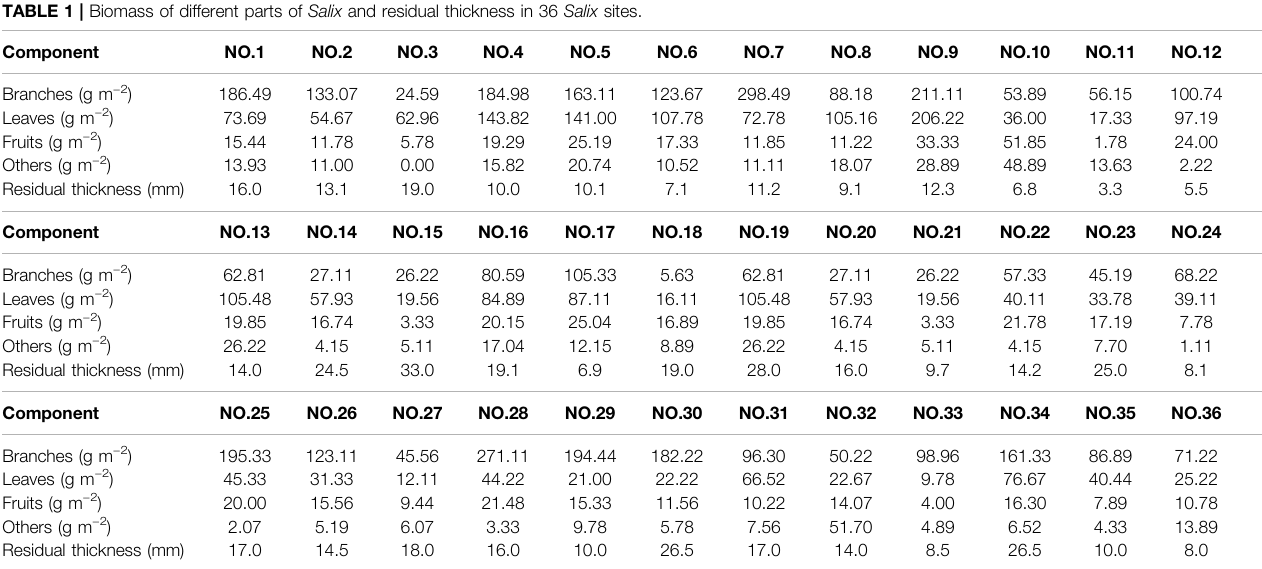
TABLE 1 | Biomass of different parts of Salix and residual thickness in 36 Salix